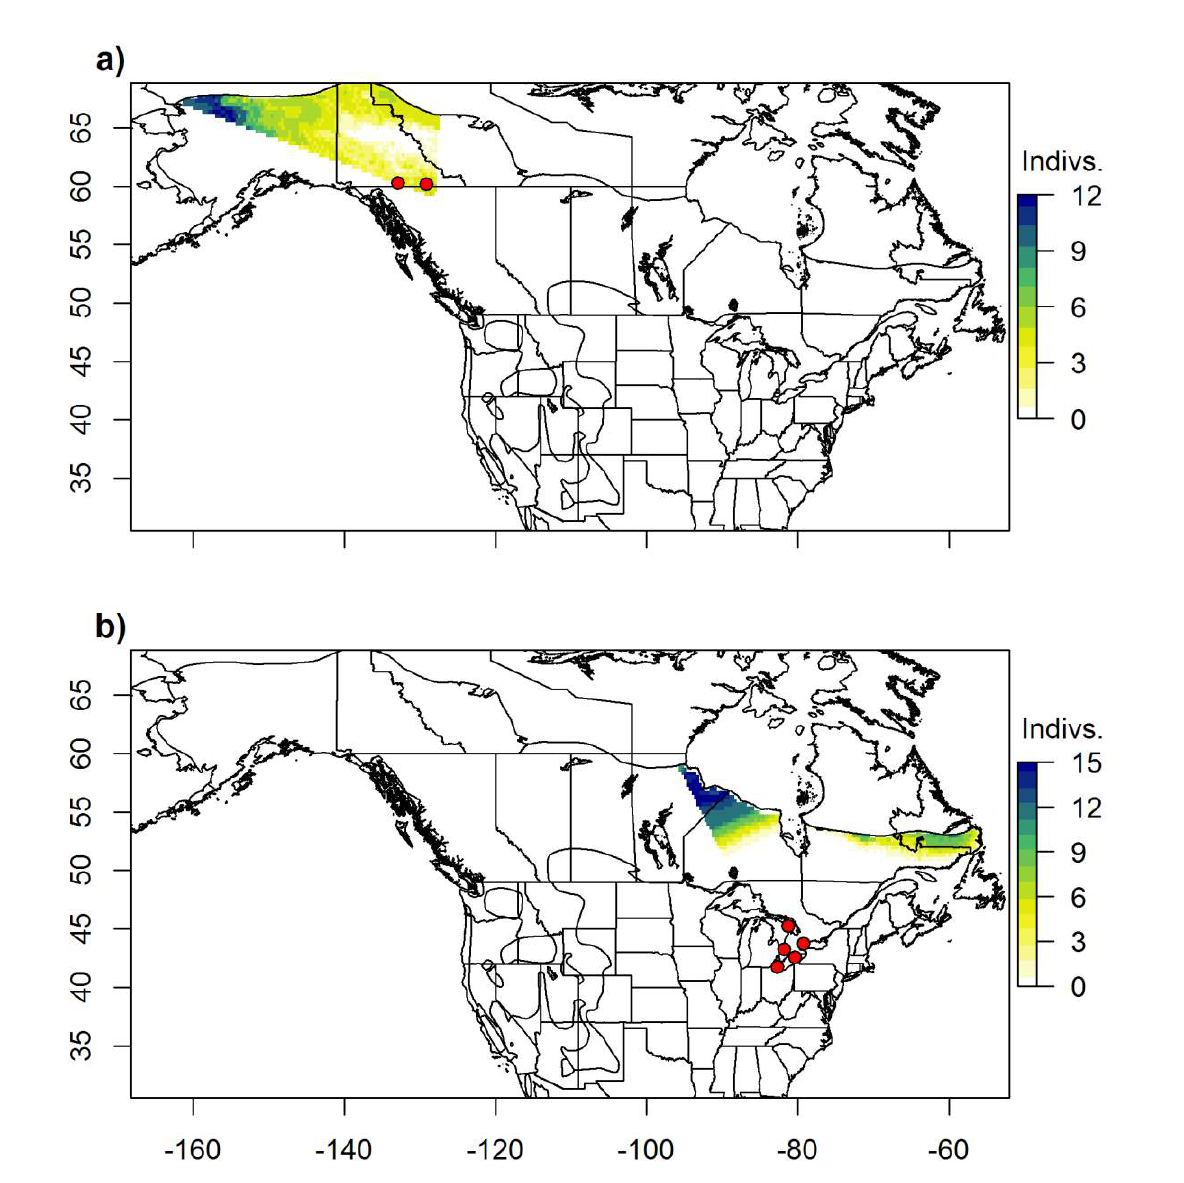
Figure A2.11: Probable origins of Orange-crowned Warblers ( Oreothlypis celata ) captured during spring migration at CMMN stations in a) the Yukon (ACBO (n=12), TLBBS (n=7)) and b) Southwest Ontario (AuBO (n=2), BPBO (n=11), LPBO (n=3), TTPBRS